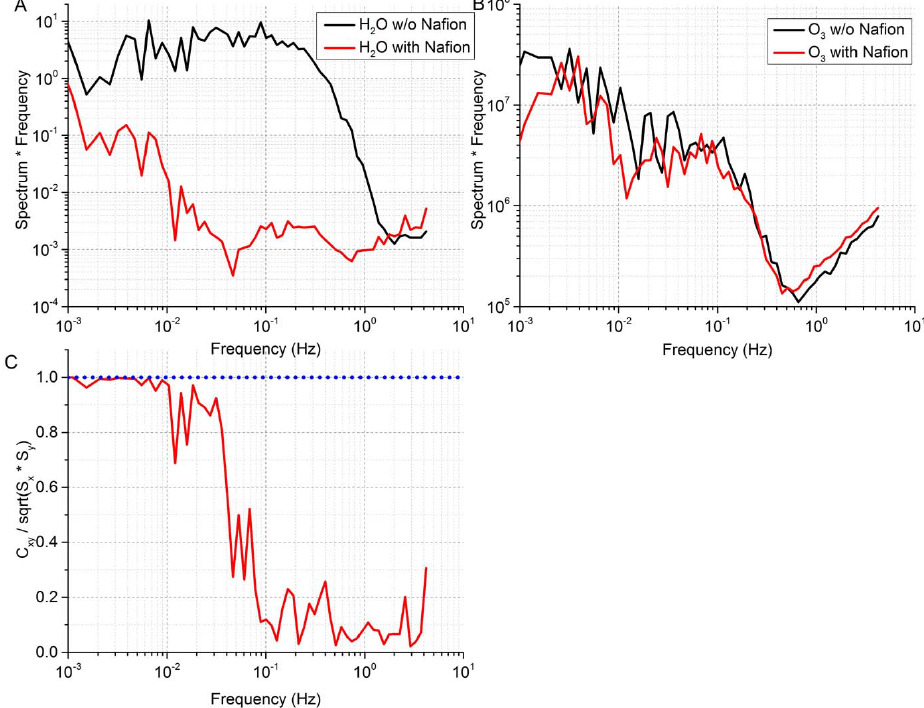
Fig. 7. Spectral distribution plots using two consecutive 2h periods of data from the same hydrometer and ozone instrument, with and without the Nafion dryer. All plots use the same x axis range. The sample air contained ∼ 40nmolmol − 1 of ozone and ∼ 6.0mmolmol − 1 of water vapor in the flow path. (A) Power spectra of ambient water vapor with (red) and without (black) the Nafion drying system. (B) Power spectra of the ozone signal with (red) and without (black) the Nafion drying system. (C) Coherency spectral distribution of the ambient water vapor